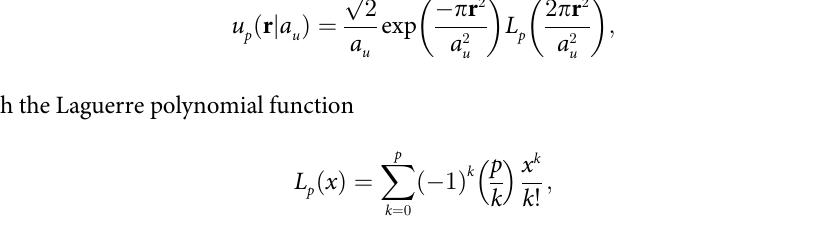
PLOS ONE | https://doi.org/10.1371/journal.pone.0267850 May 19,